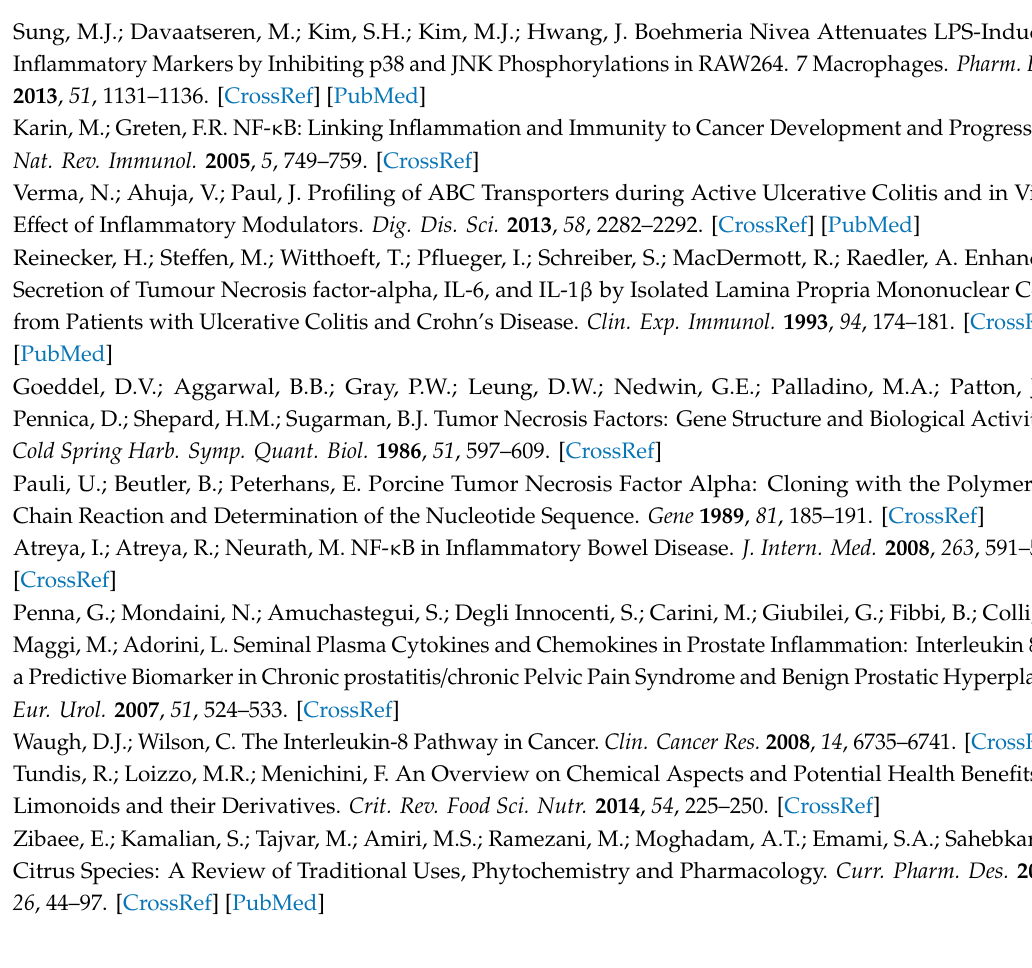
Figure S1: 1 H-NMR spectra of compound 1; Figure S2: 13 C-NMR spectra of compound 1; Figure S3: 1 H- 1 H COSY spectrum of compound 1; Figure S4: HMQC spectrum of compound 1; Figure S5: HMBC spectrum of compound 1; Figure S6: DEPT spectrum of compound 1; Figure S7: HRESIMS of compound